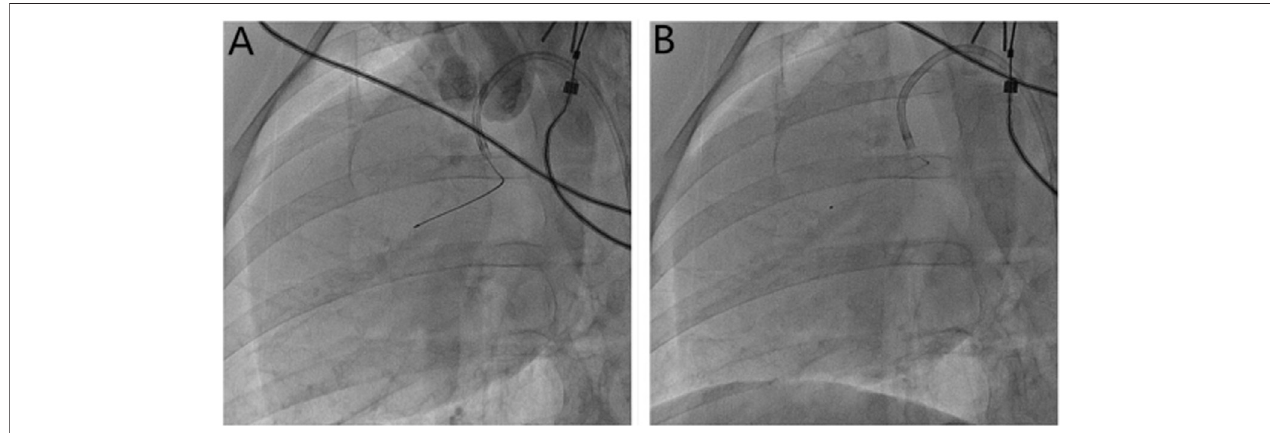
FIGURE 1 | Microsphere injection method. (A) Measurement of the length of the anterior descending branch of the microcatheter (30 mm) with Maker; (B) the microcatheter is fi xed, the guide wire is withdrawn, and the microspheres are injected through the microcatheter.